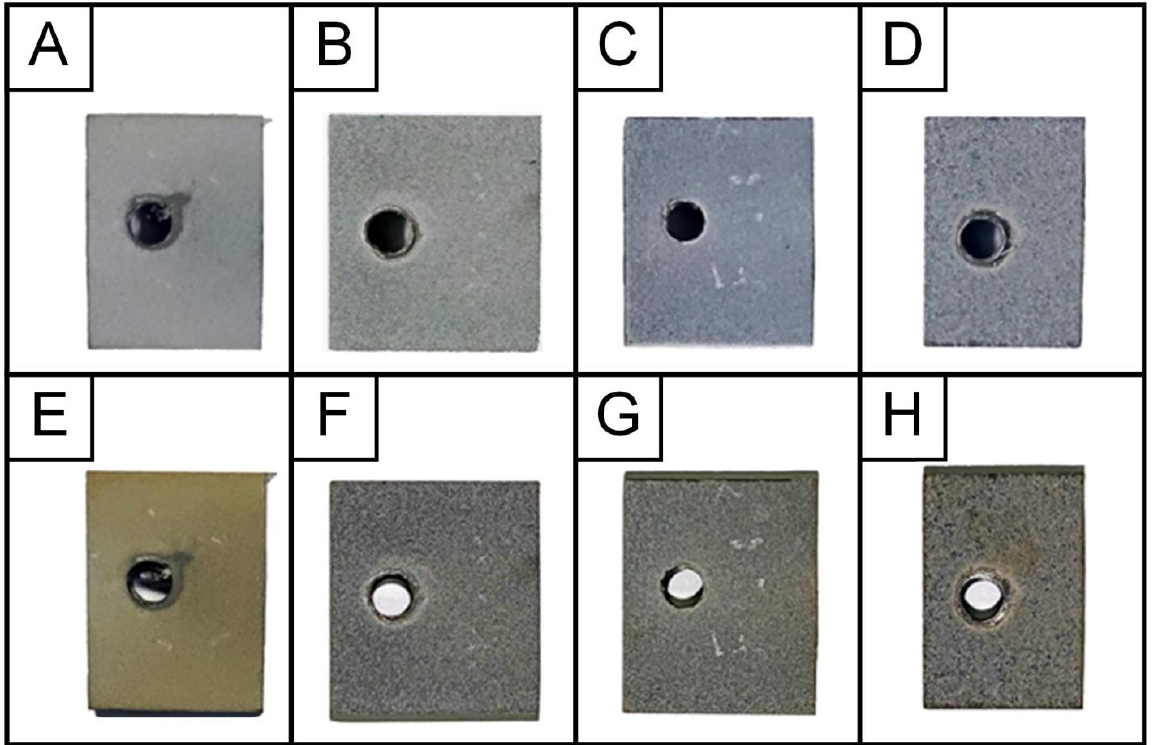
Figure 2. Samples with MAO coatings Ti-MAO-10-30 ( A , E ), Ti-MAO-10-60 ( B , F ), Ti-MAO-20-30 ( C , G ), and Ti-MAO-20-60 ( D , H ), before ( top row ) and after ( bottom row ) TCT.